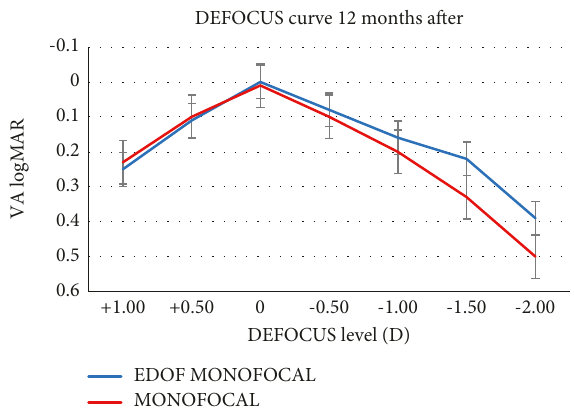
Figure 2: The defocus curve obtained binocularly with uncor- rection (EDOF: extended depth of focus; logMAR: logarithm of the minimum angle of resolution; VA: visual acuity).